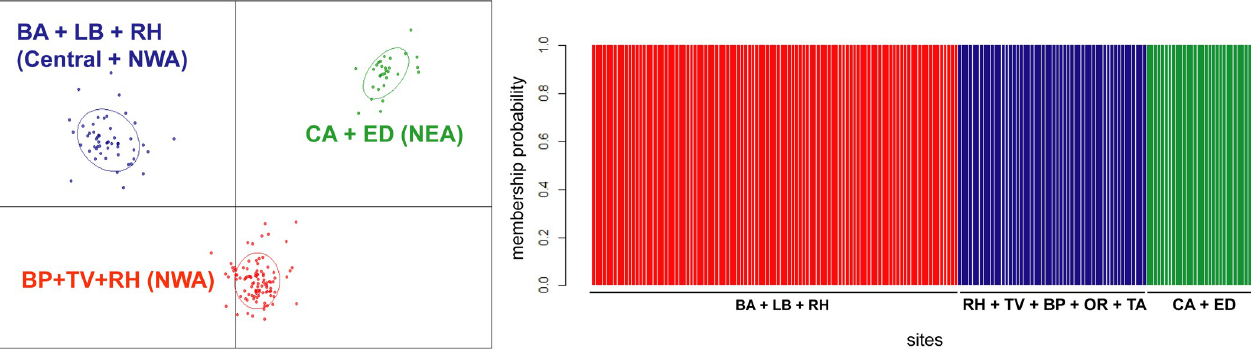
Fig 5. DAPC analysis for Ae . aegypti samples from different locations in Northwestern, Northeastern and Central Argentina. On the left, scatter plot with individuals (dots) assigned to the three detected clusters using the k means function find.clusters. On the right, individual membership probability to each cluster (vertical lines).